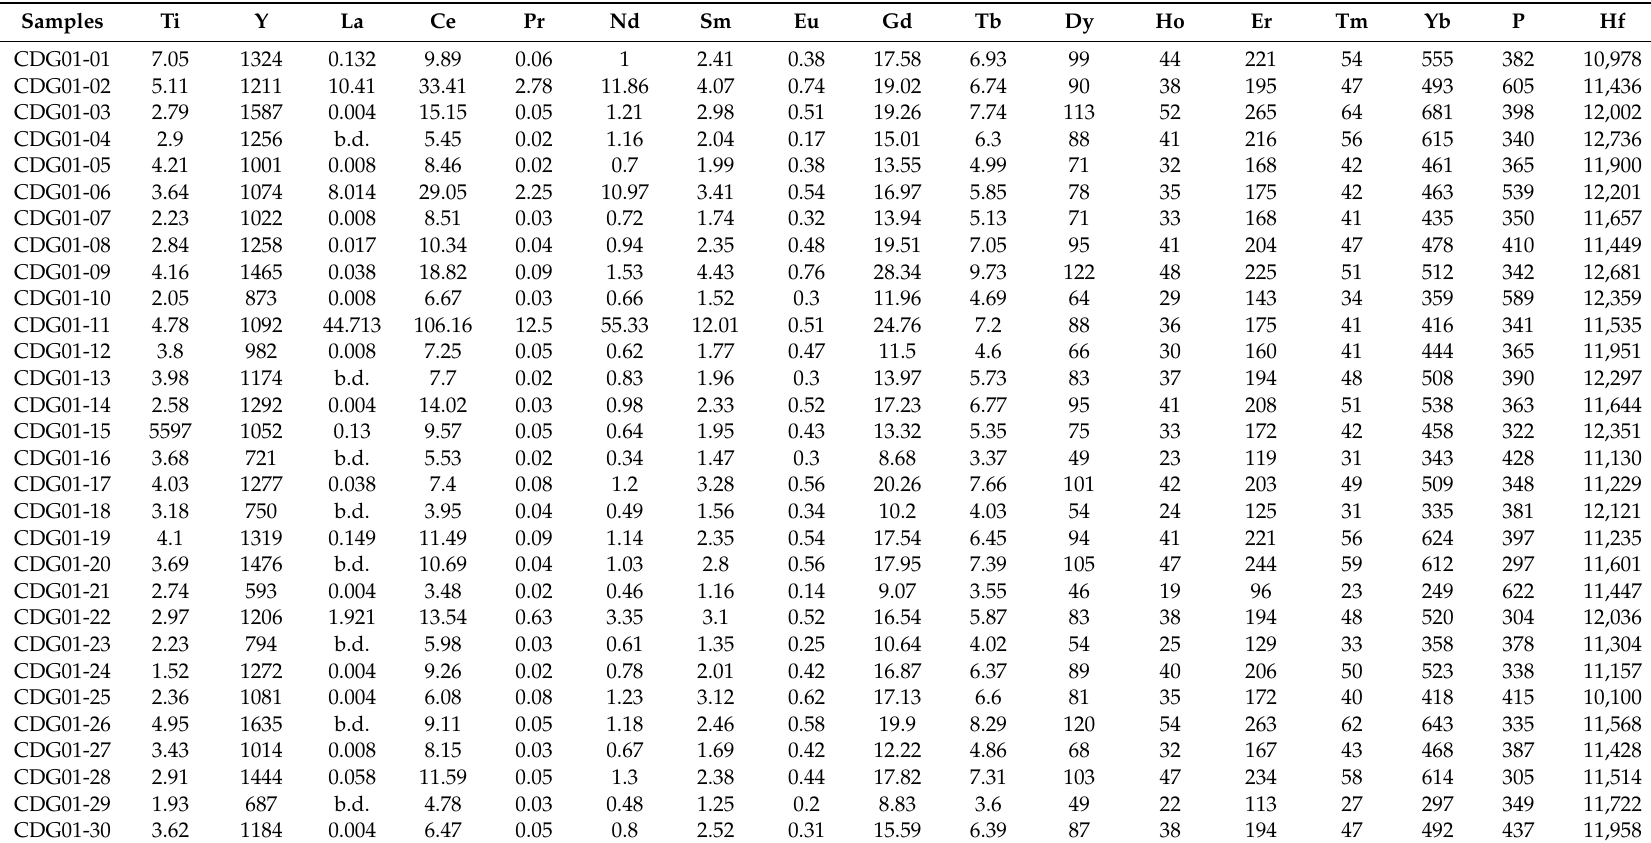
Table 2. Trace element concentrations of zircon grains from Changdagou granodiorite